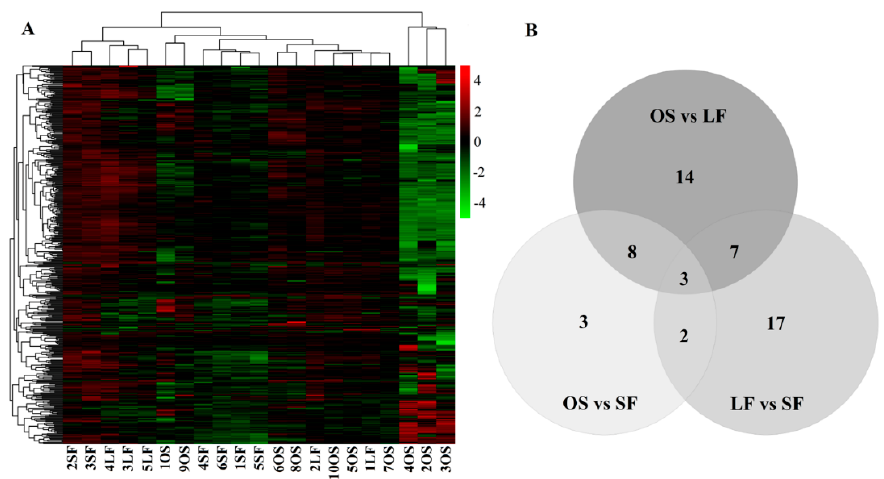
Figure 3. Expression profiling of miRNAs in OS vs. LF, OS vs. SF, and LF vs. SF. ( A ) Heatmap of all miRNAs. ( B ) Venn map of DEmiRNAs in OS vs. LF, OS vs. SF, and LF vs. SF.